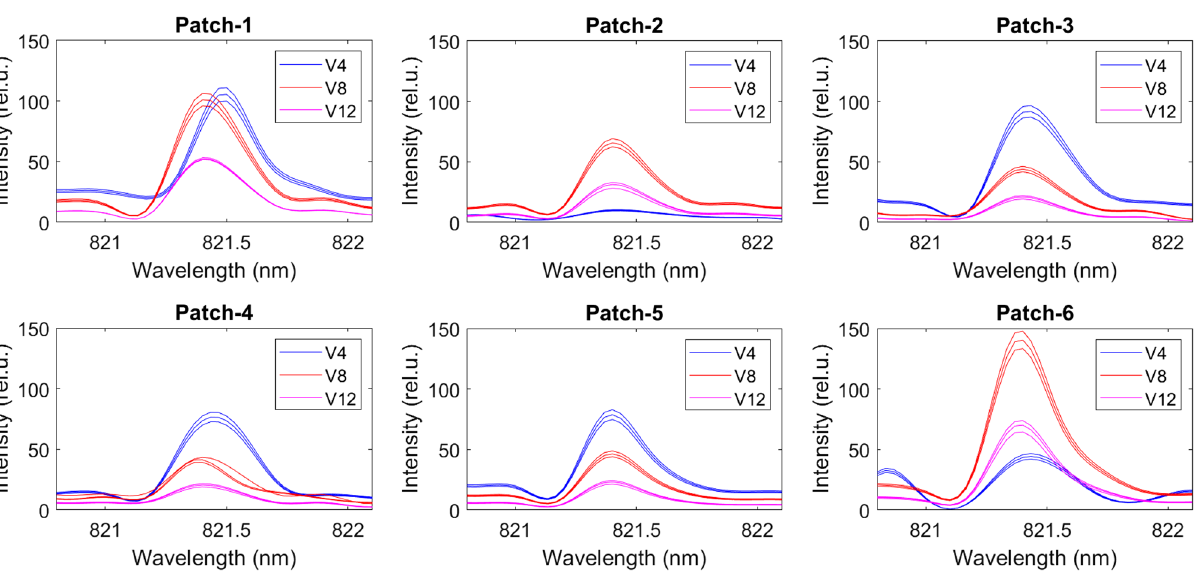
Figure 6. Nitrogen spectrum of the soil samples at 821.4 nm for six patches at the V4, V8 and V12